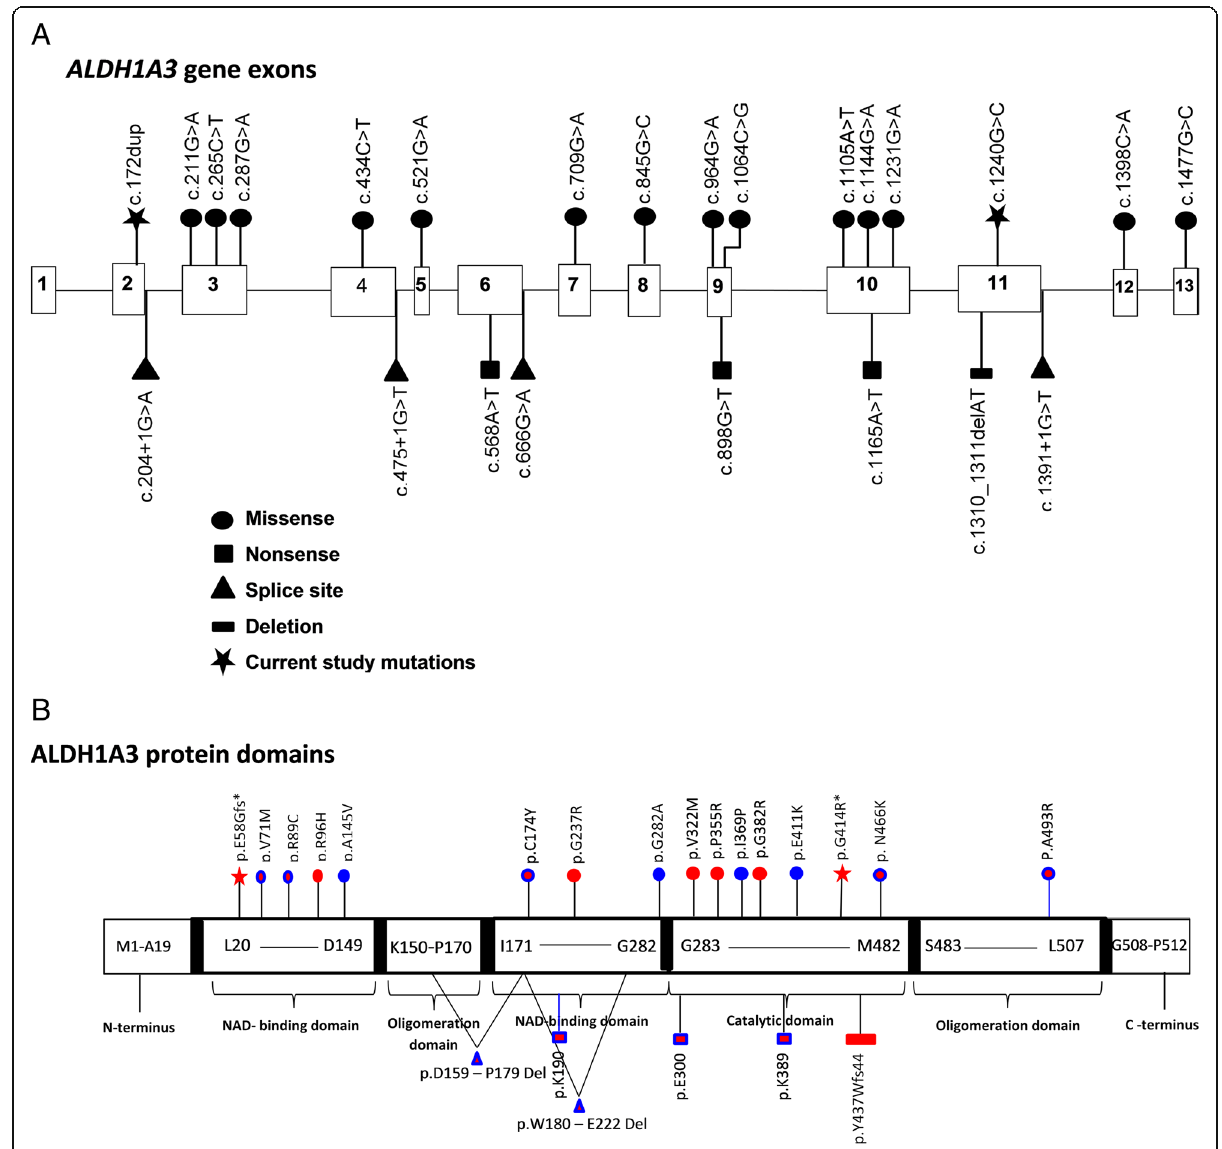
Fig. 2 ALDH1A3 gene mutations associated with anopthalmia and microphthalmia. a Schematic representation of exons of the ALDH1A3 gene highlighting the positions of all disease causing mutations identified to date. b Domains of predicted protein product as described by Moretti and colleagues [11], highlighting the positions of all disease associated variants identified to date. Discrete color pattern of variants shows type of phenotype (red: anophthalmia, blue: micophthalmia and a combination of red and blue: both anophthalmia and